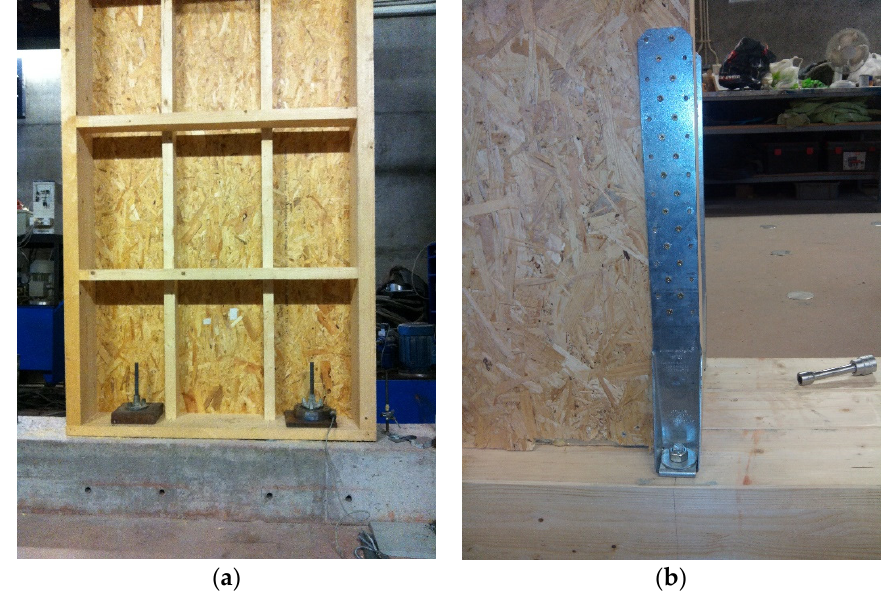
Figure 5. Fixation of the panels to the base. ( a ) Fixation with steel rods; ( b ) fixation with hold ‐ down.